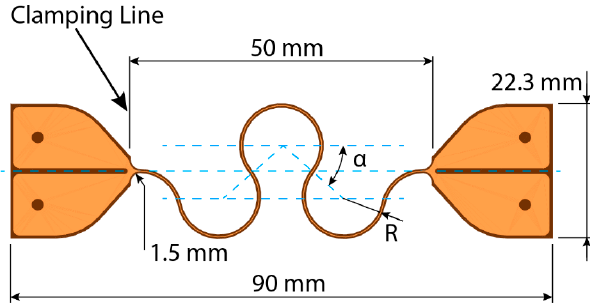
Figure 5. Design of the test vehicle with horseshoe-shaped meanders used for the tensile tests. R is the radius of the horseshoe-shaped meander segment, while α is the opening angle. These two variables combined completely define a horseshoe-shaped meander. To provide a smooth transition to the contact pads, a small 1.5-mm fillet was introduced at both ends. The contact pads at either side of the meander were split up to enable a four-point measurement with separate drive and sense lines. Table 1. Design parameters for the tested interconnects.